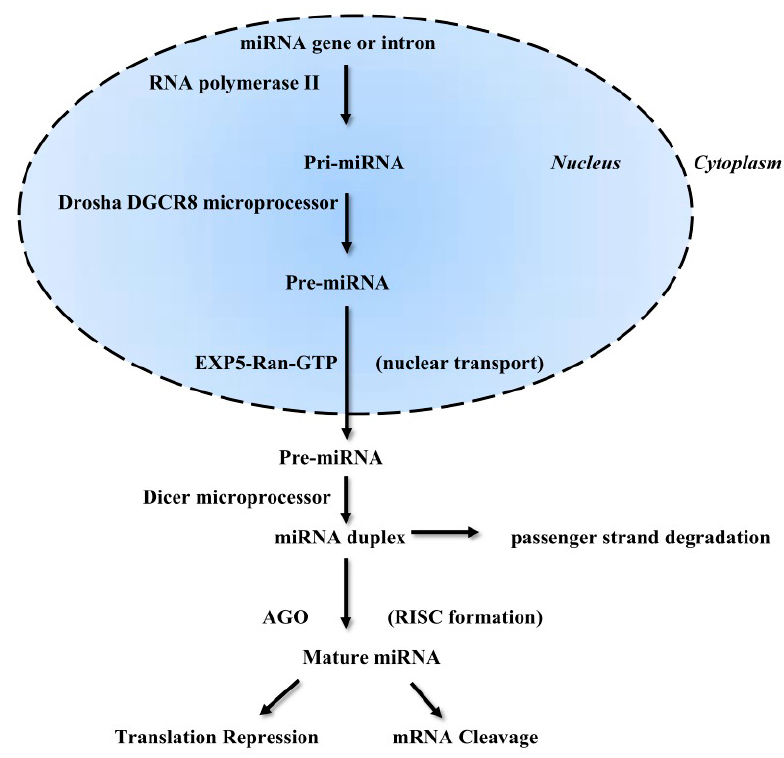
Figure 1. MicroRNA maturation and function. RNA polymerase II synthesizes primary miRNA. Next, pri-miRNA is processed by the Drosha DGCR8 microprocessor in the nucleus. The produced pre-miRNA is transported to the cytoplasm with the participation of EXP5-Ran-GTP. In the next step, the Dicer microprocessor creates a mature miRNA from pri-miRNA by removing the loop. The mature miRNA with AGO protein forms RISC to stop the translation of a target mRNA.